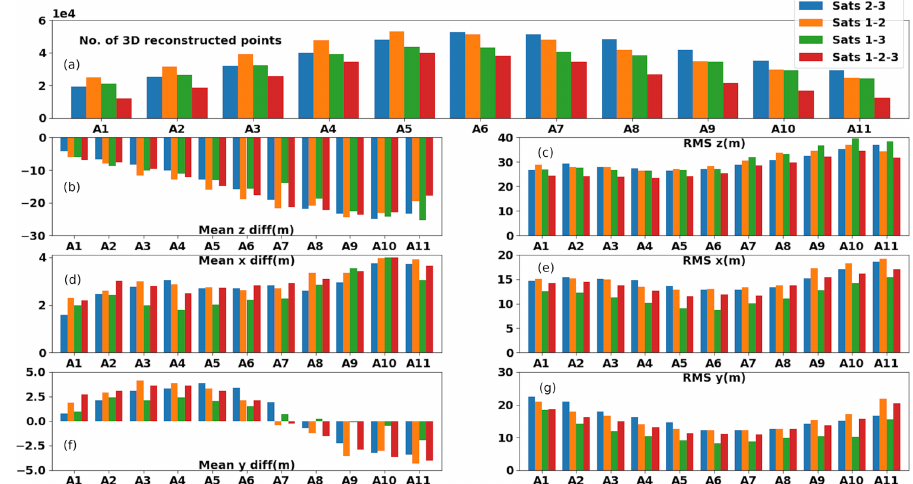
Figure 10. Results of the testing of the 3D retrieval for the cumulus case. (a) Number of stereo-retrieved points as a function of the acquisition number (A5, A6 are close to nadir) for two vs. three satellites and for B = 150km (Sats 2–3 and Sats 1–2) and B = 300km (Sats 1–3). (b, d, f) Mean difference between ST and GT point clouds for each acquisition along z , x , y . (c, e, g) Root mean square error (RMSE) of the difference between ST and GT point clouds for each acquisition along z, x , y